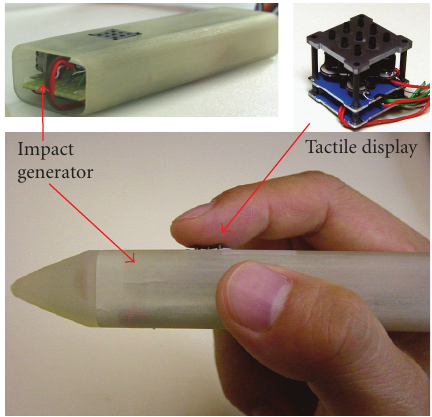
Figure 3: The prototype of the Ubi-Pen II.